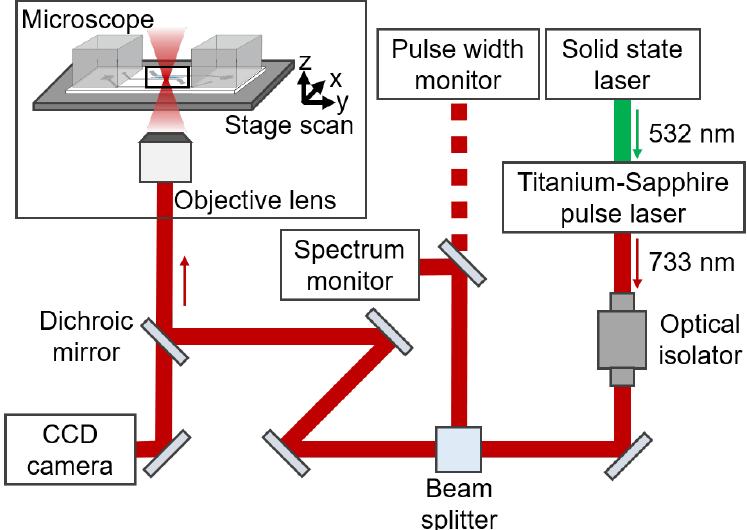
Figure 2. Experimental setup for laser scanning. The experimental setup comprised a solid-state laser, titanium-sapphire pulse laser, optical isolator, CCD camera, inverted microscope, and optical elements including mirrors, lenses, and monitors.